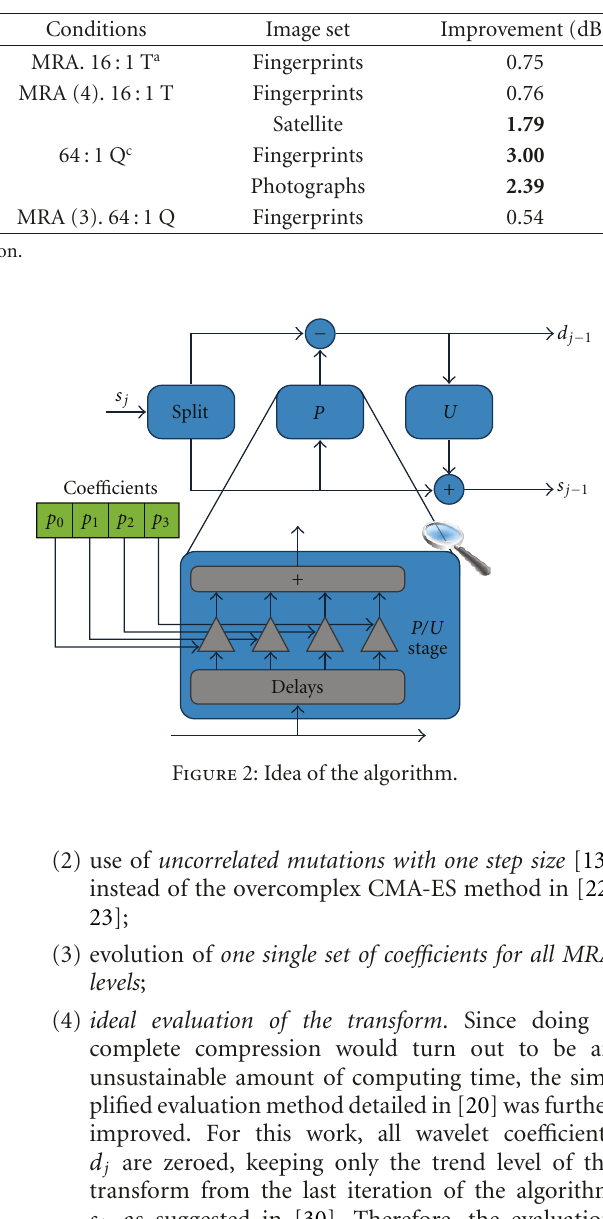
Table 1: State of the art in evolutionary wavelets design.